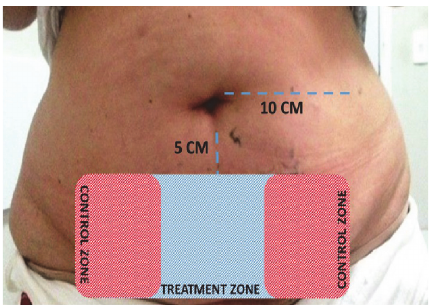
Figure 1: Marked area for treatment (treatment zone and control zone). Each area had 10cm × 10 cm, with total surface 30 × 10cm.